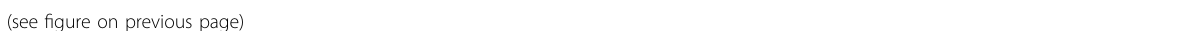
Fig. 3 Depletion of Kindlin-2 increases apoptosis and inhibits phagocytosis in Sertoli cells. A Left: Ki67 was detected in 4 and 8 W WT and KO testes by immunohistochemical analyses. Scale bar, 50 μ m. Right: The quanti fi cation of Ki67 positive cells in one Seminiferous tubule. Data are mean ± s.e.m. The variance was similar between the groups. * p < 0.05, ** p < 0.01 and *** p < 0.001 by Student ’ s t -test. B TUNEL detection for apoptosis (red) in WT and KO testes samples at 2, 4 and 12 W. The nuclei were stained blue with DAPI. KO testes showed increased apoptosis signaling at 2 W testes compared with WT testes. Scale bar, 50 μ m. C Flow cytometry analysis were used to analyze the apoptosis rate in TM4 and 15P-1, transfected with control or Kindlin-2 siRNA separately. Knock down of Kindlin-2 induced more apoptosis in both TM4 and 15P-1 cells. D The Sertoli cell lines TM4 and 15P-1 were transfected with control or Kindlin-2 siRNA for 48 h. Cells were lysed and immunoblotted for Cleaved Caspase 3. β -actin was used as a loading control. Experiments were repeated three times. E Immuno fl uorescence staining of EZ-link sulfo-NHS-LC-biotin tracer was performed in wild type and KO mice testis. WT mice show restriction of biotin tracer to the basal compartment, while KO mice show spreading of biotin tracer dye in seminiferous tubules. Scale bar, 50 μ m. Circles indicate the seminiferous tubules, and arrows showed the biotin entering seminiferous tubules through blood testes barrier. F Immuno fl uorescence of α -tubulin (green) was performed 3 h after the microbeads phagocytosis test in Kindlin-2 siRNA compared with control siRNA in 15P-1 cells. Scale bar, 50 μ m. G Quanti fi cation for the phagocytosis ratio in control and Kindlin-2 siRNA in 15P- 1 cells. Cells treated with Cytochalasin D were used as negative control. Statistical analyses were performed using Student ’ s t -test. The variance was similar between the groups. *** p < 0.001. H Immunohistochemistry staining for ABP in testes from 4 W WT and KO mice testis. Scale bar, 50 μ m. Magni fi cations were shown on the right panel. I Western blot analyses of ABP in testes from 4 W KO and WT mice. GADPH acts as an internal reference. J Representative western blot analyses of ABP and Kindlin-2 using speci fi c antibodies through loss of function of Kindlin-2 in two cell lines TM4 and 15P-1. GADPH acts as an internal